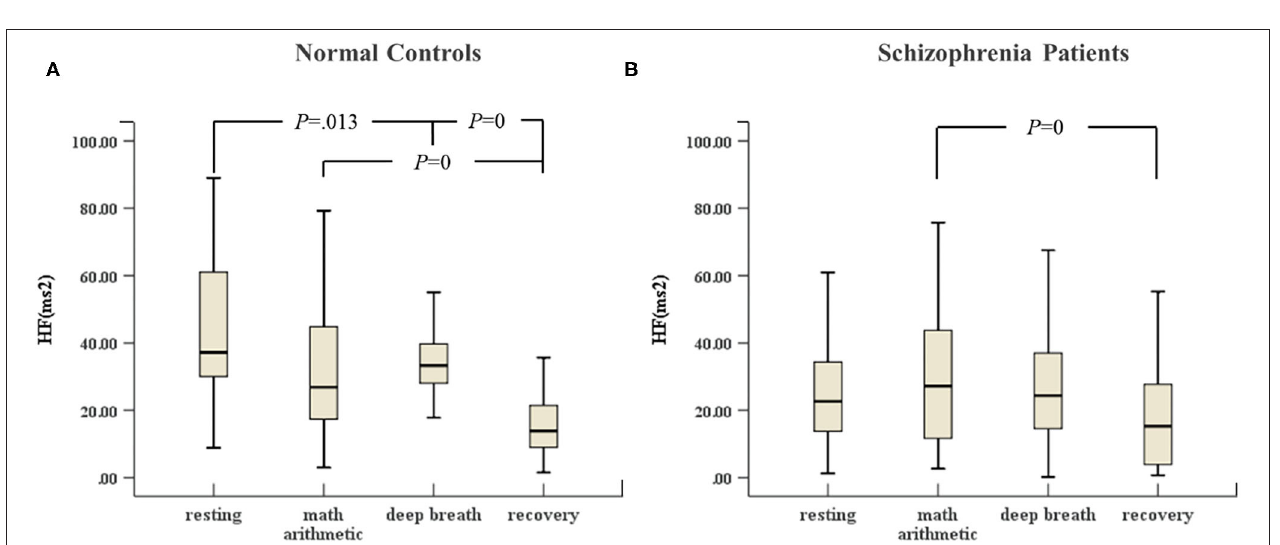
FIGURE 2 | (A) HF of HRV of normal controls ( n = 45) and (B) HF of HRV of schizophrenia patients ( n = 45) during the ANS test, which was analyzed with ANOVA, p <